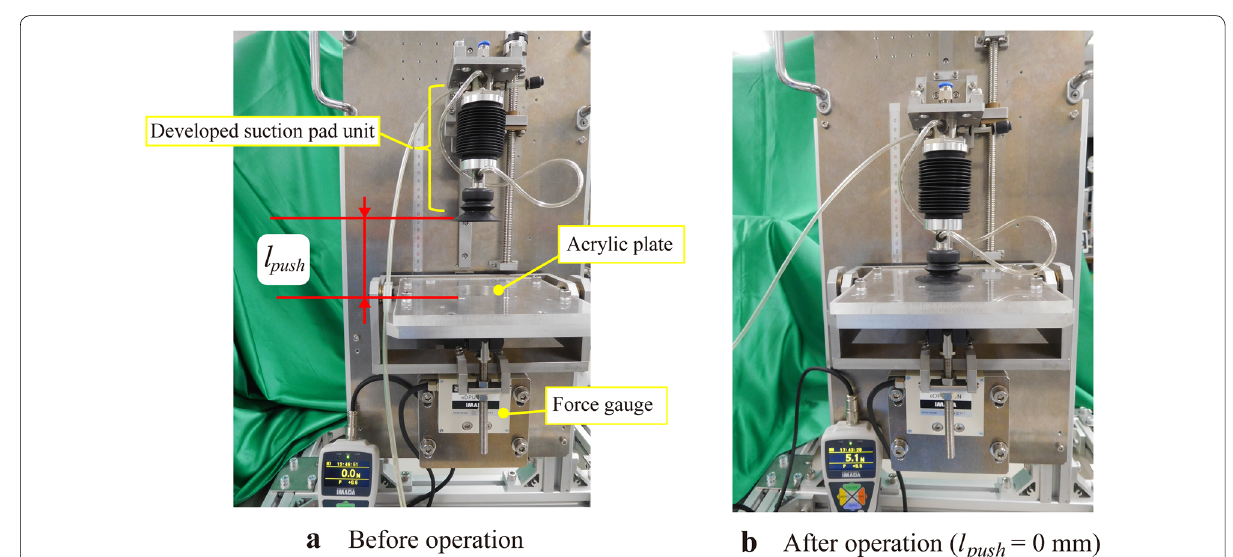
Experiment 1‑3: evaluation of contraction force by a suction pad